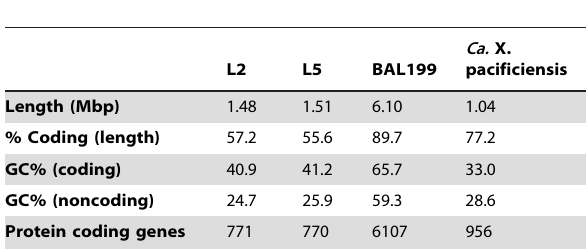
Table 1. Comparison of Ca. E. faulkneri, BAL199 and estimated Ca. X. pacificiensis genomes.